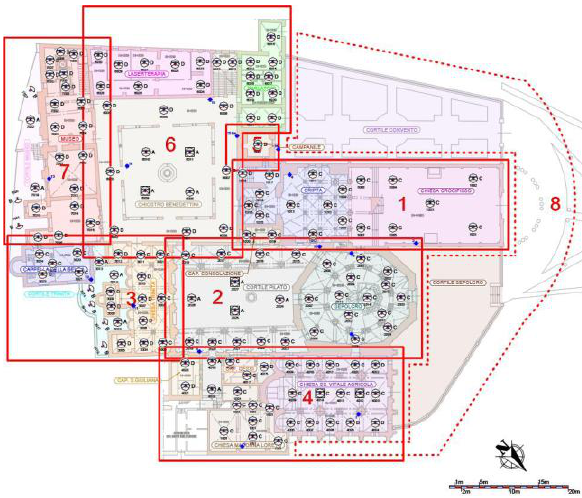
Figure 3. Map of the scanning positions during the survey of St. Stefano Basilica. In order to ensure greater readability, the map shows only some of the performed scanning locations and in particular those relating to the ground